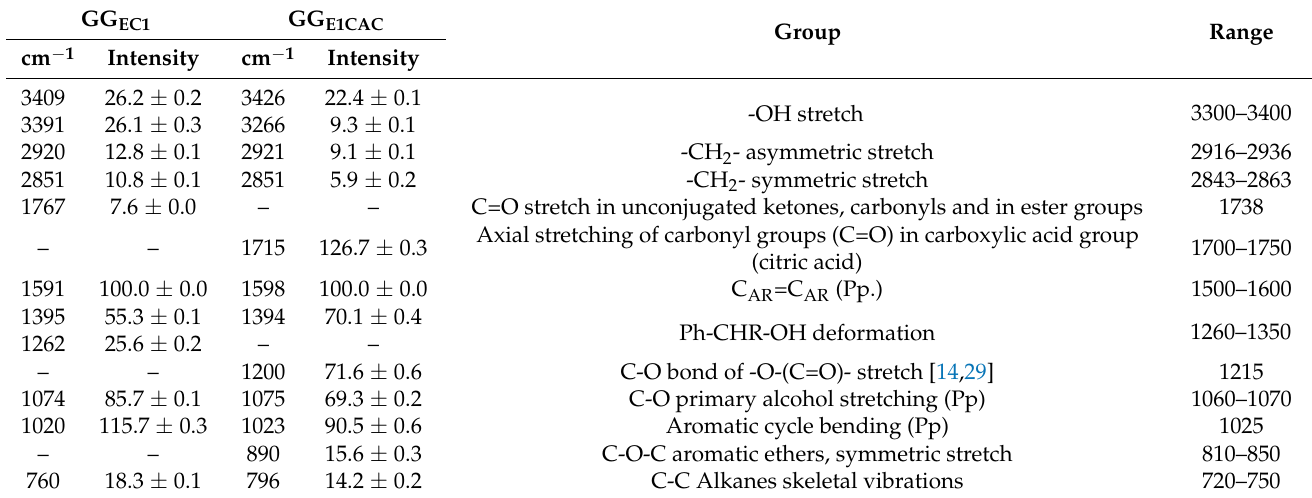
Table 5. FTIR peak assignment of grape cane extracts cured alone and with citric acid at 120 ◦